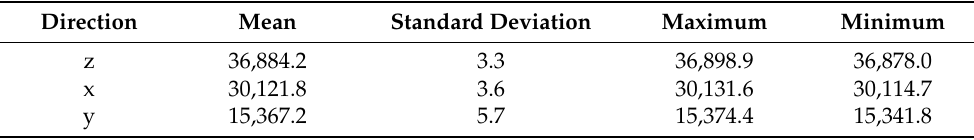
Table 4. Statistical table of environmental magnetic field